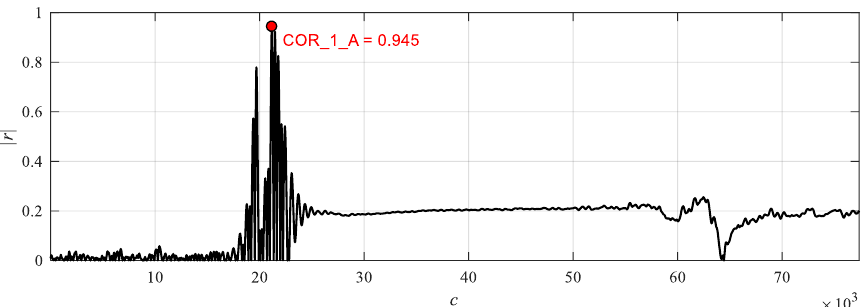
Figure 13. Signature determination algorithm for the HF-COR method.